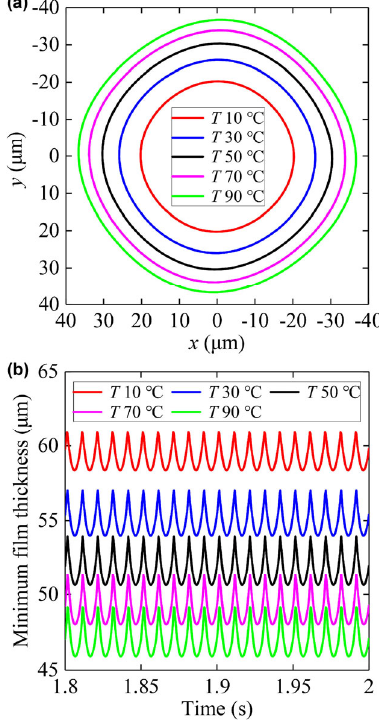
Fig. 16 (a) Journal center orbits and (b) dynamic minimum film thicknesses of a TPJB without static loads for different water